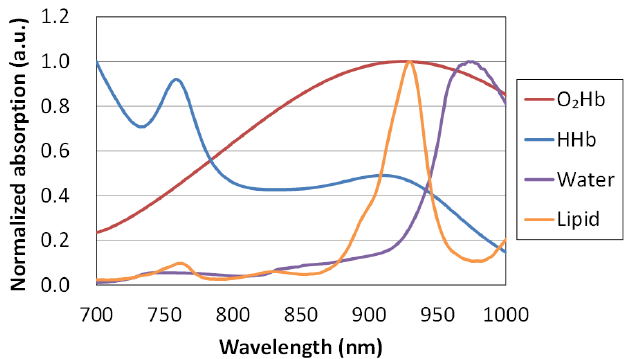
Figure 2. Absorption spectra of oxy-hemoglobin (O 2 Hb), deoxy-hemoglobin (HHb), pure water, and purified lard.